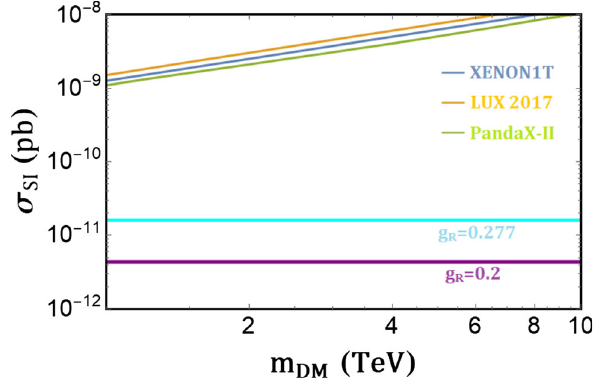
Fig. 11 Spin-independent dark matter-nucleon scattering cross- section, σ (in pb) as a function of the dark matter mass m DM with different gauge coupling g R = 0 . 2 , 0 . 277. Here we set m Z (cid:2) = 10 TeV. Yellow, blue and green color solid lines represent current direct detectioncross-sectionlimitfromLUX-2017[81],XENON1T[82]and PandaX-II (2017) [83] experiment